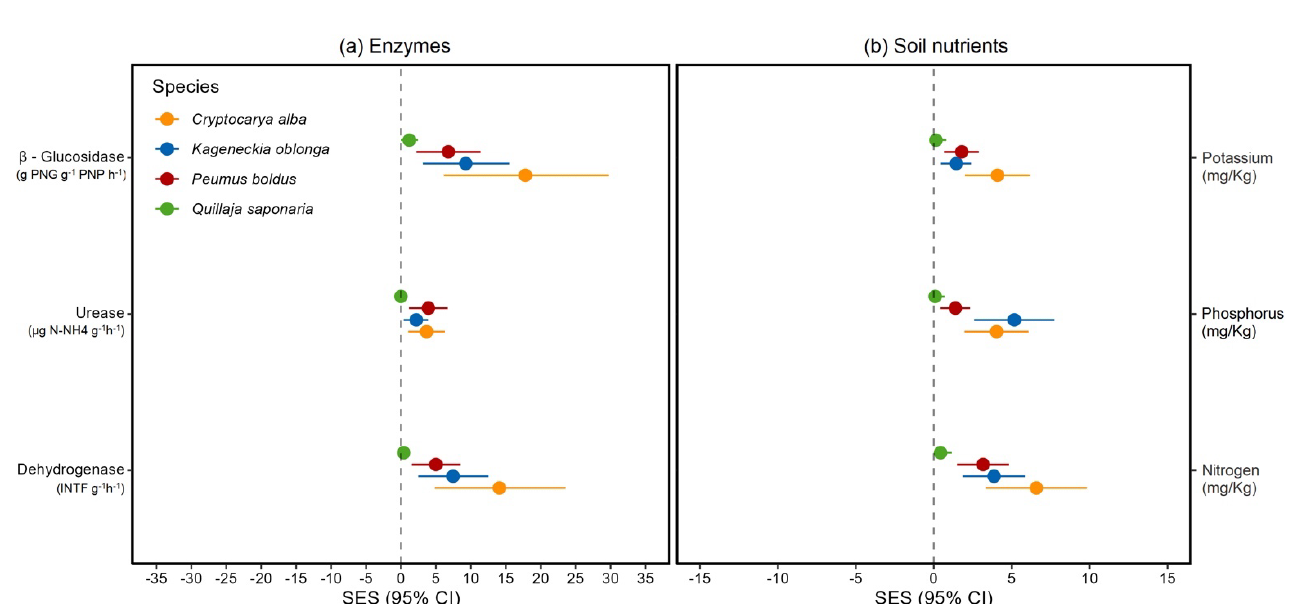
Figure 3. Effect size of ( a ) enzymatic activity and ( b ) soil nutritional content in four dominant woody plant species from the Chilean Mediterranean ecosystem (MTE), after a wildfire inoculated (M+) and not inoculated (M−) with AMF. SES with 95% CI measured after 24 months for urease, β –glucosidase, and dehydrogenase are shown. A mean effect size is significantly different from zero when CIs do not overlap zero. Negative (or positive) effect sizes indicate that inoculated plants (M+) have on average greater (or lesser) enzymatic activity or soil nutritional content than not inoculated plants (M−).